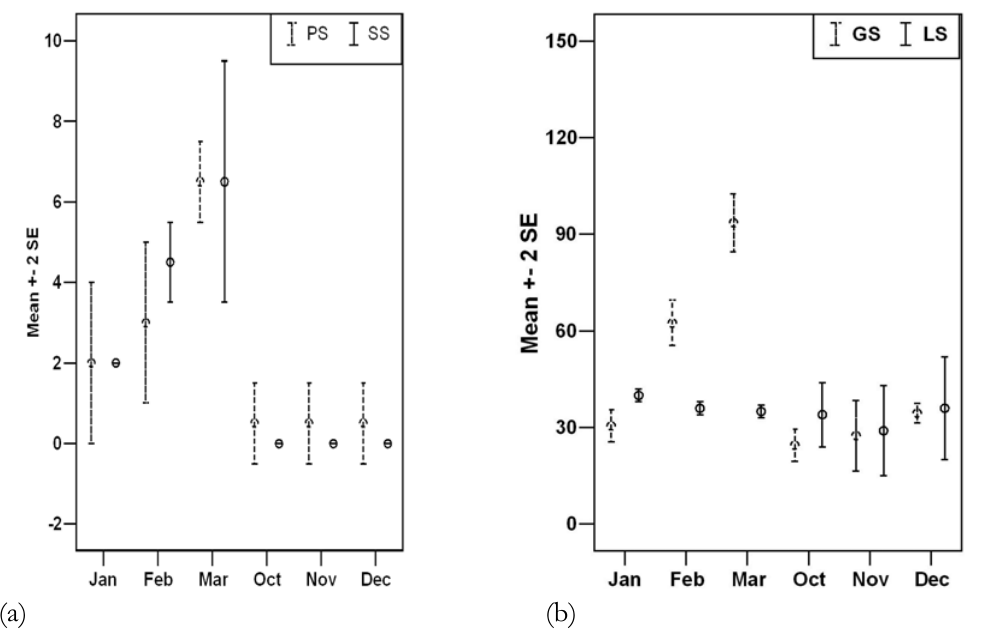
F IG .1.- Ranges of changes (Mean±SE) of (a) PS and SS, and (b) GS and LS, during hibernation period from October to March.